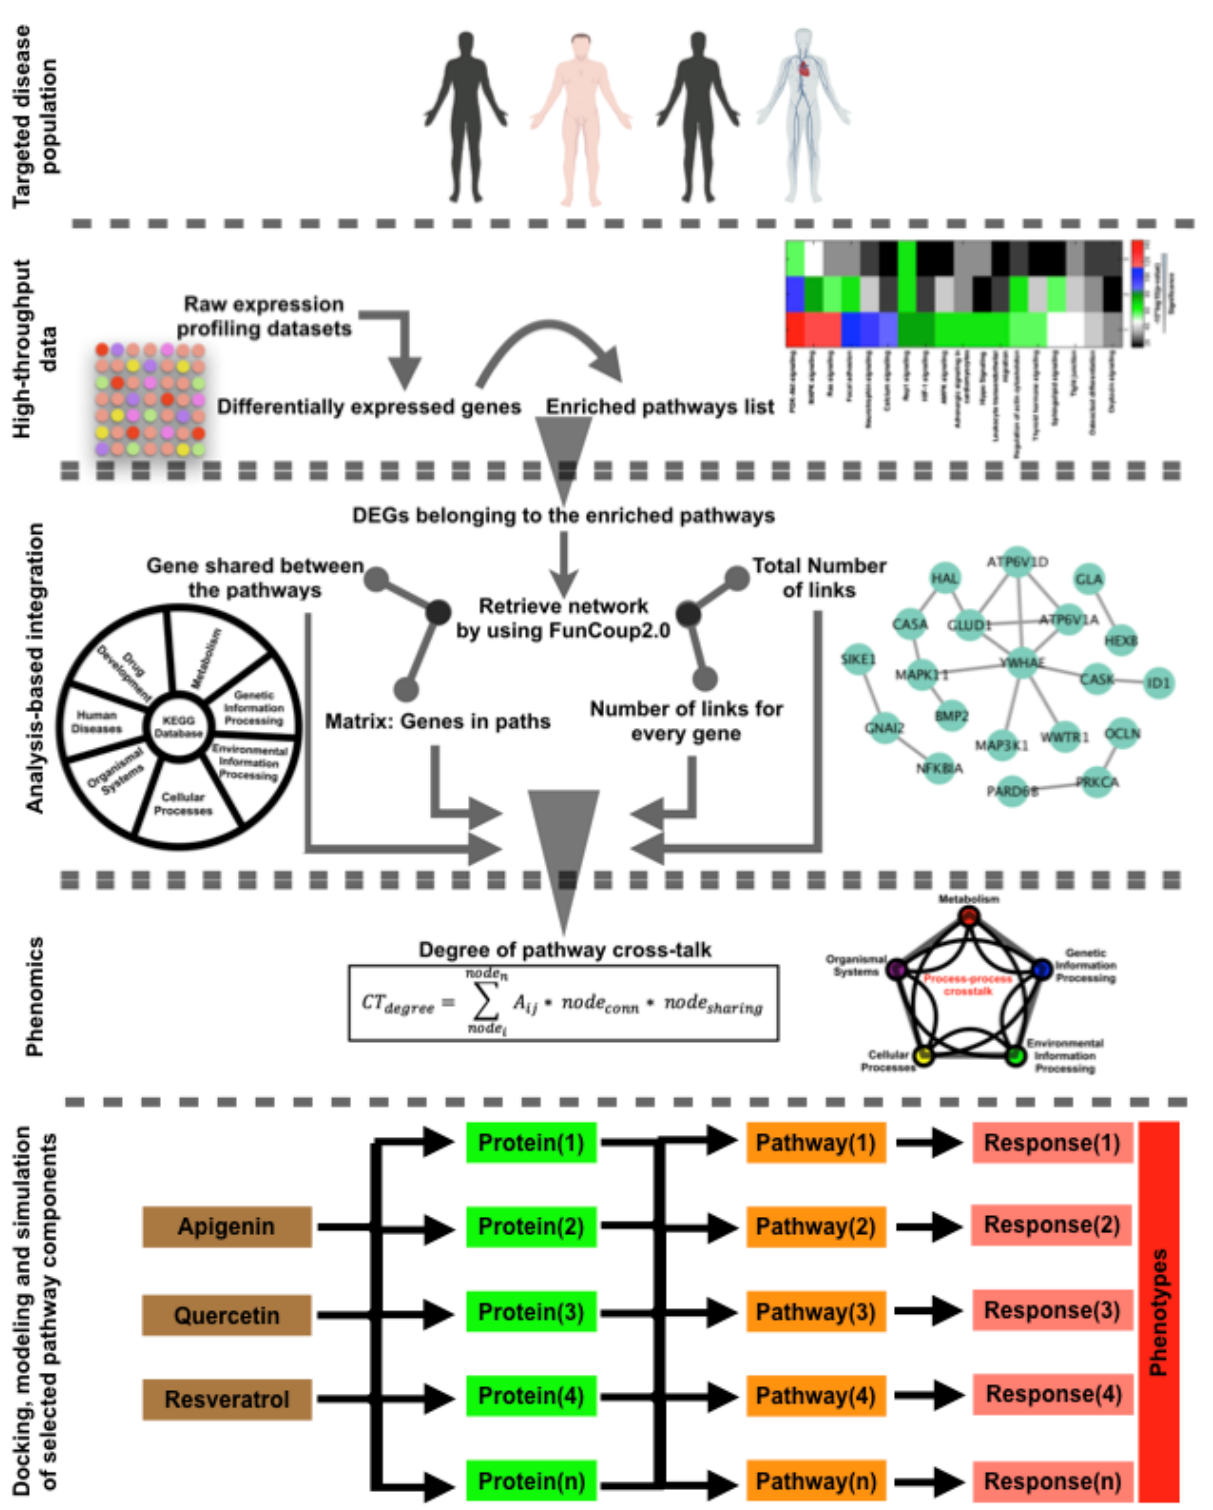
Figure 1. GECIP (Gene set, Enrichment, and Crosstalk between the Inferred Pathways) workflow for pathway enrichment analysis and crosstalk degree calculation for the enriched